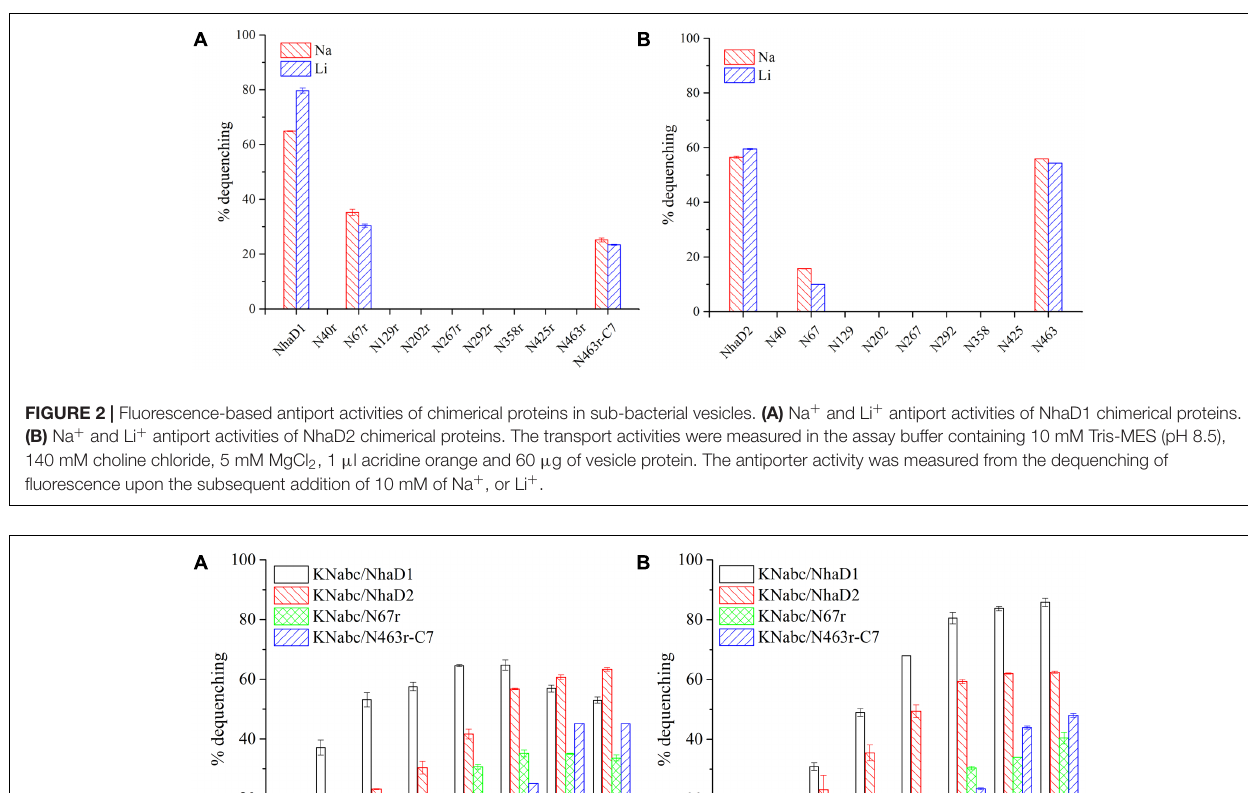
The medium contains indicated concentrations of NaCl or LiCl and measured at 600 nm (OD 600 ) after 24 h of cultivation. Each strain was tested in three replicates.